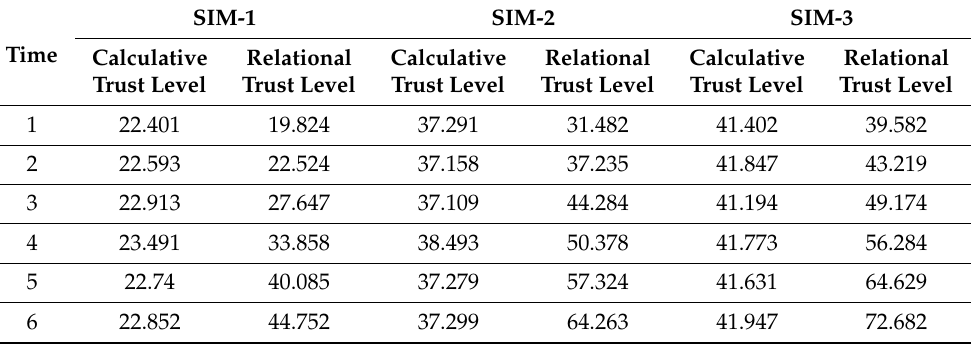
Table 5. Scenario D simulation